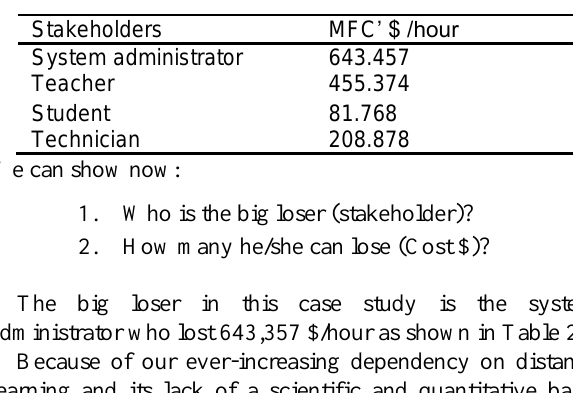
Table 2: The initial MFC application for e- learning